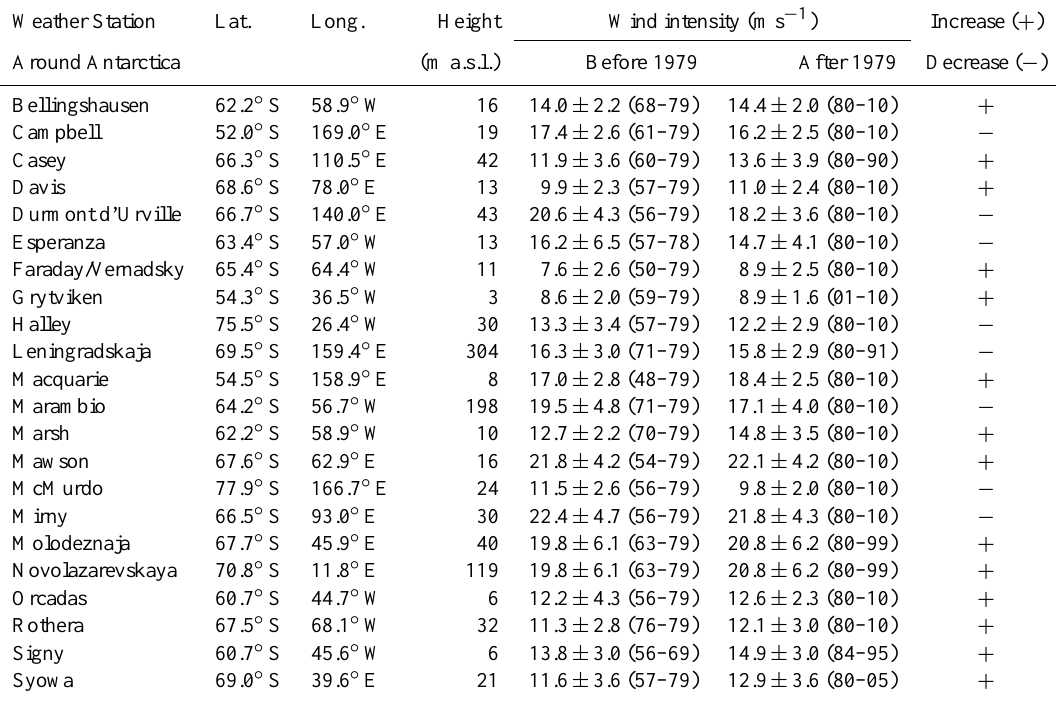
Table 1. Trends in surface wind intensity measured in Antarctic stations (maritime region) before and after 1979. Data compiled from the SCAR-READER database. “Increase” and “Decrease”, ( + / − ), refer to trends. Weather Station Lat. Around